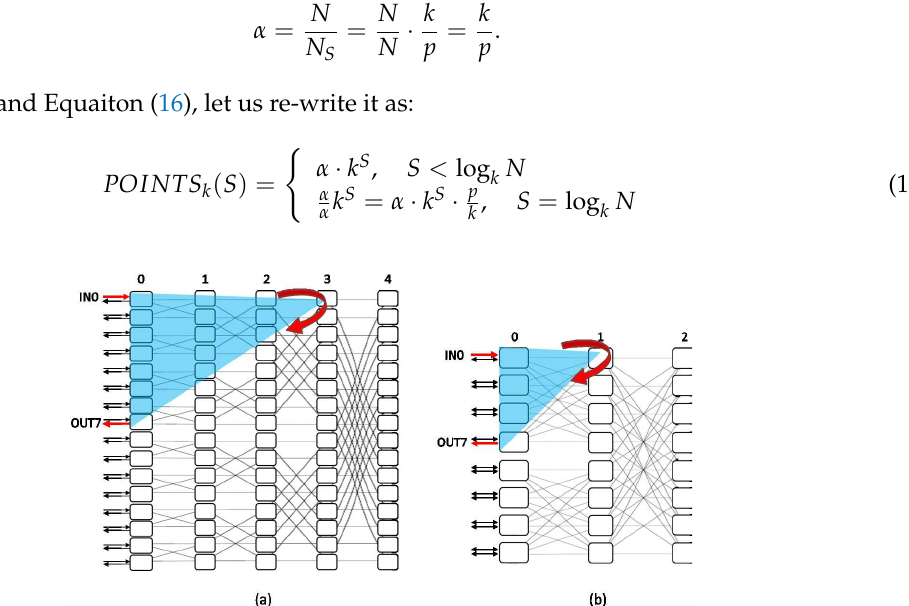
Figure 11. Example of fully-bypassed MSSN connectivity with 16 × 16 I/Os: radix-2 ( a ) and radix-4 ( b ). For a generic stage S , the number of points subtended from a cone of the previous stage ( S − 1 )